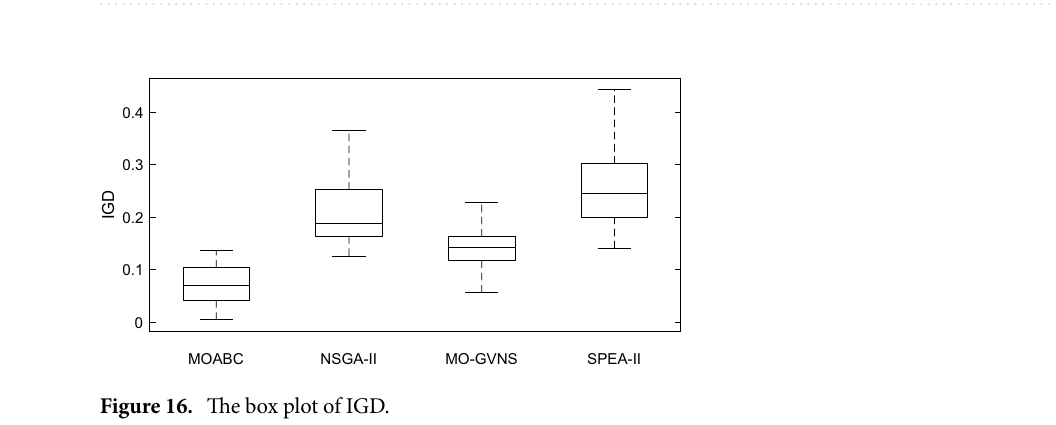
Figure15. Box plot of C-metric for MOABC vs. other three algorithms.